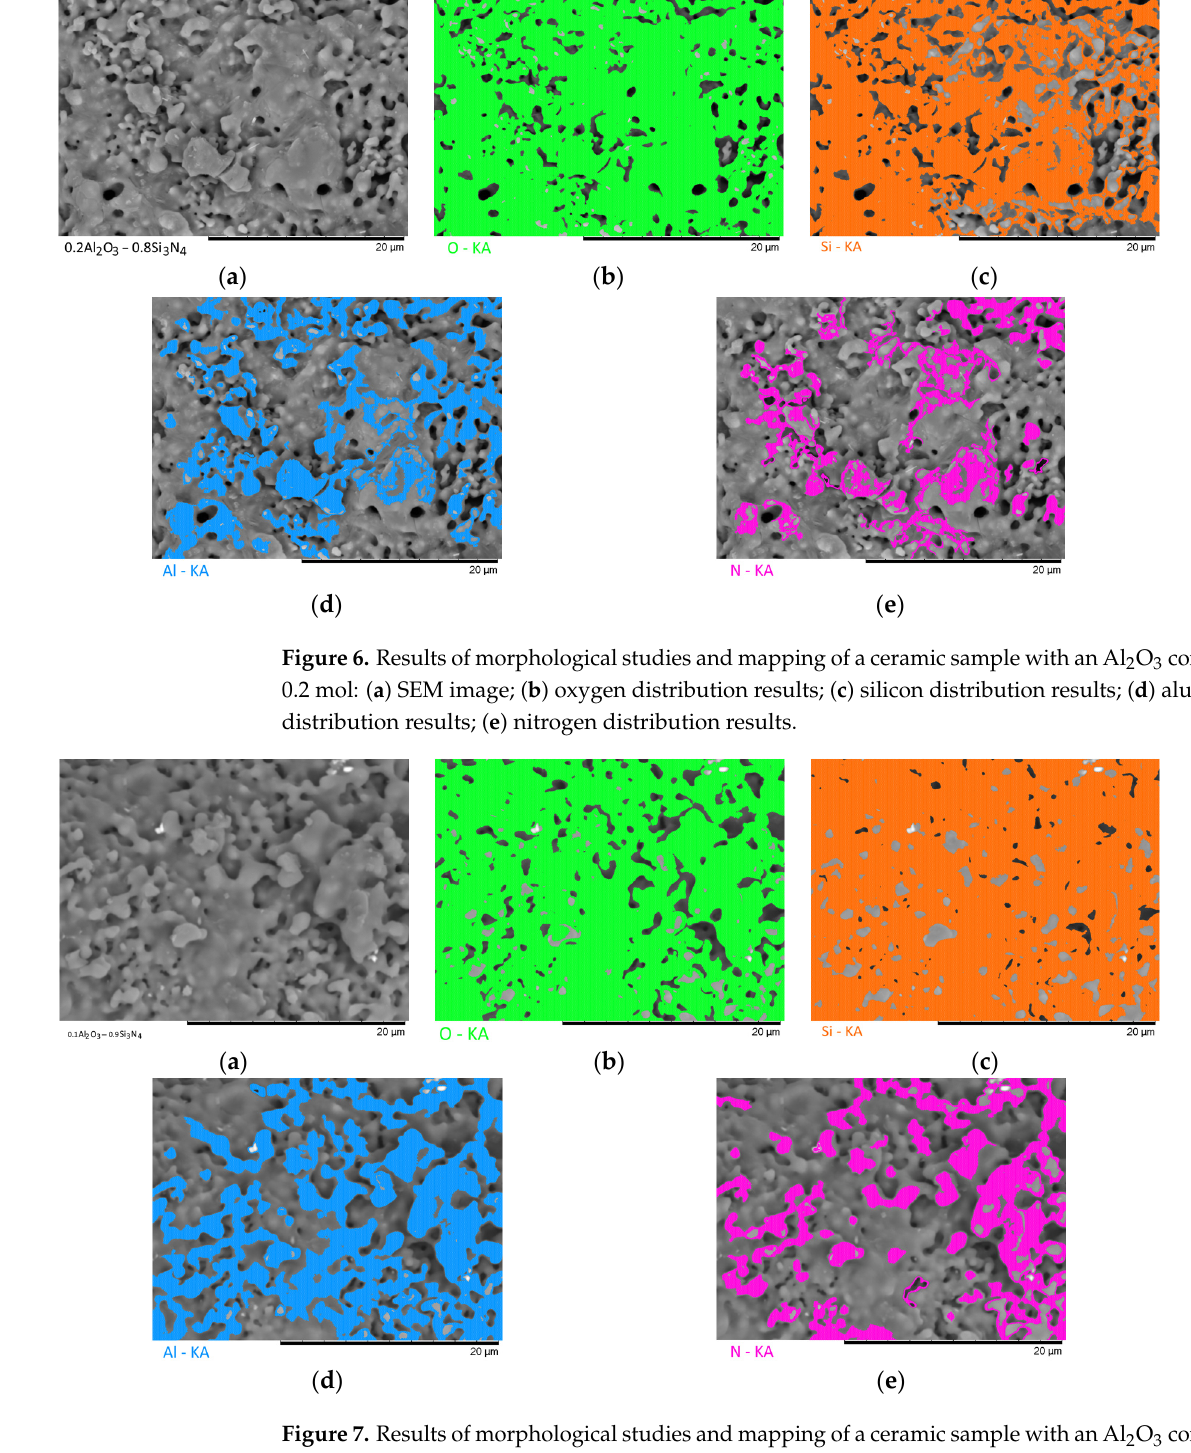
Figure 7. Results of morphological studies and mapping of a ceramic sample with an Al 2 O 3 content of 0.1 mol: ( a ) SEM image; ( b ) oxygen distribution results; ( c ) silicon distribution results; ( d ) aluminum distribution results; ( e ) nitrogen distribution results.